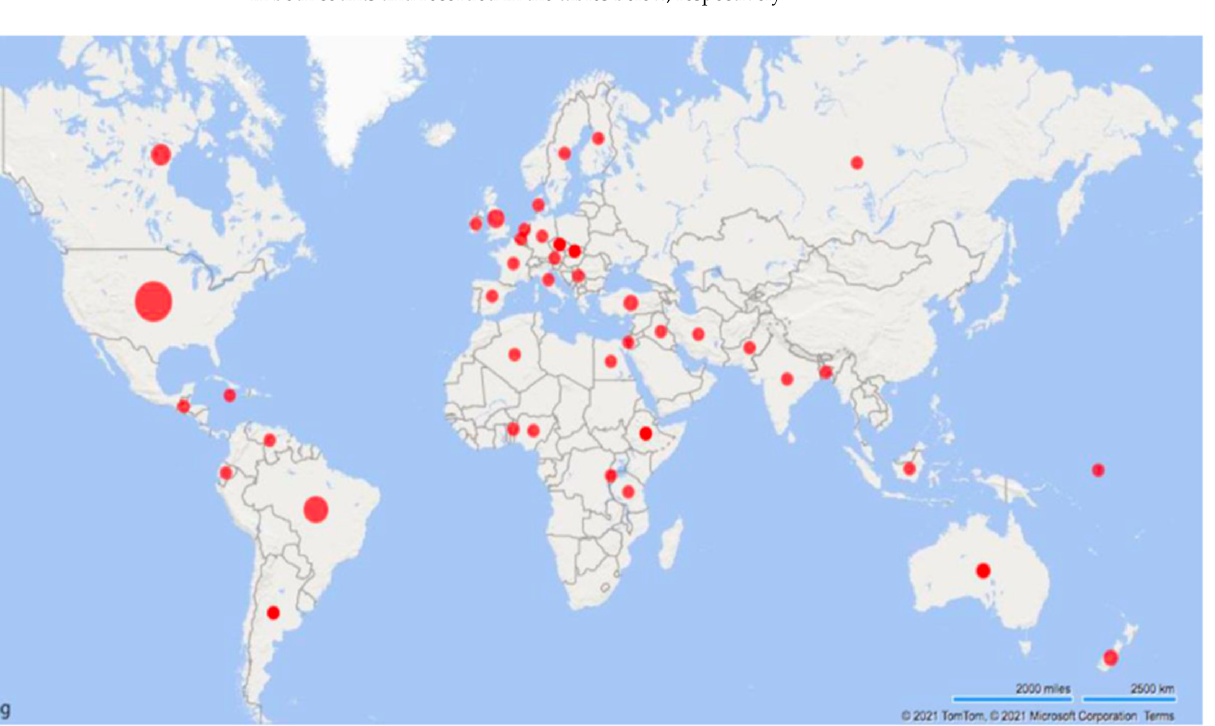
Figure 2. Map of the articles included in the scoping review characterizing umbilical health in intensively raised cattle (1931–2020). The studies ( n = 109) were completed in the USA ( n = 41), Brazil ( n = 23), Canada ( n = 13), UK ( n = 10), Australia ( n = 9), and 36 additional countries that are further described within this review. Larger dots indicate a greater quantity of studies.